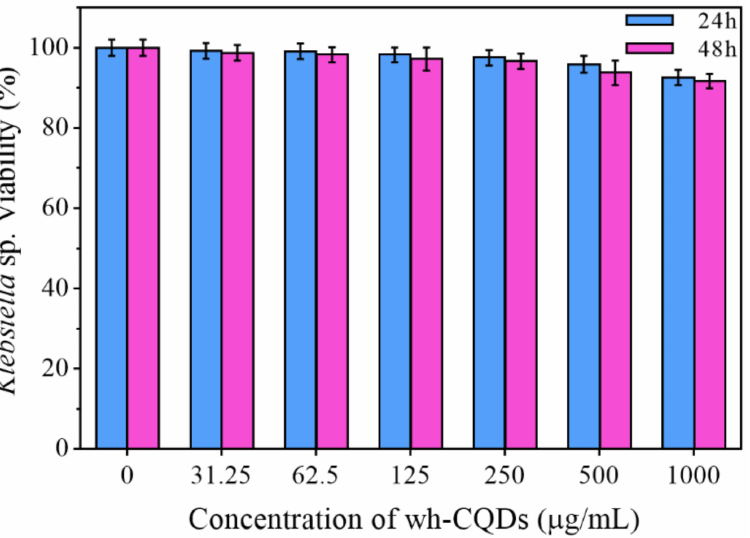
Figure 7. Cell viability assays of the Klebsiella sp. treated with different concentrations of wh-CQDs for 24 and 48